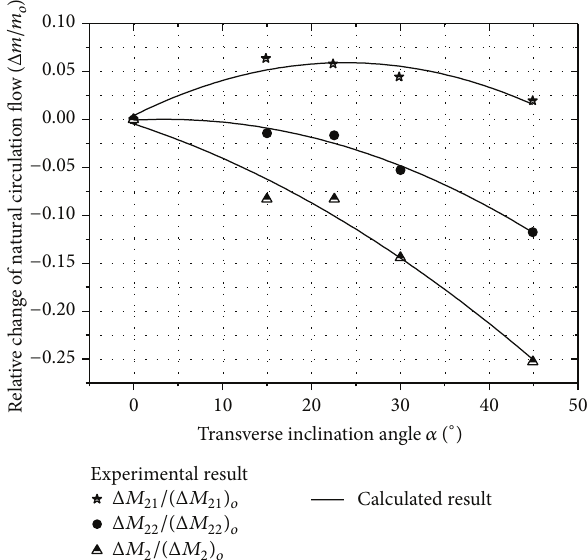
Figure 11: Comparison of experimental results and simulation results of natural circulation in inclination condition with different